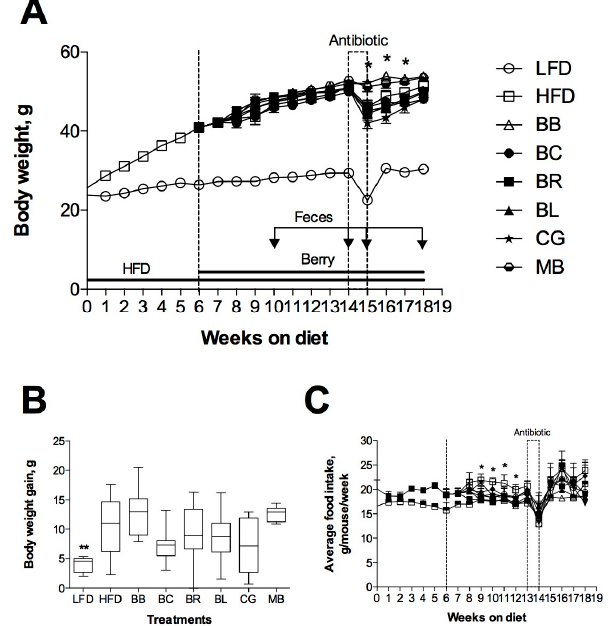
Figure 2. Effects of berry supplementation on: body weight ( A ); body weight gain ( B ); and food intake ( C ) of C57BL/6J mice. Mice were fed low fat diet (LFD) or high fat (HFD) for six weeks. DIO